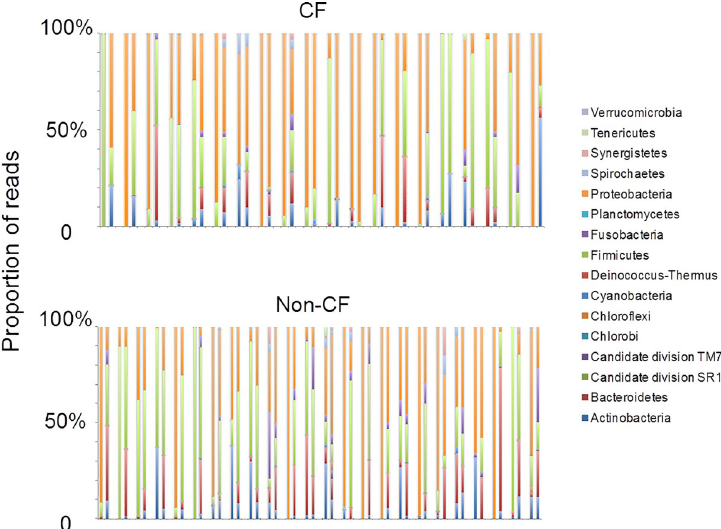
Fig 4. Phylum level composition of upper and lower airway microbiome sampled concurrently in each subject. Proportions of microbial taxa are shown on the y-axis, and paired upper and lower airway samples are shown side by side (left: BAL; right: Throat) for comparison. Top: CF children; bottom: non-CF controls.